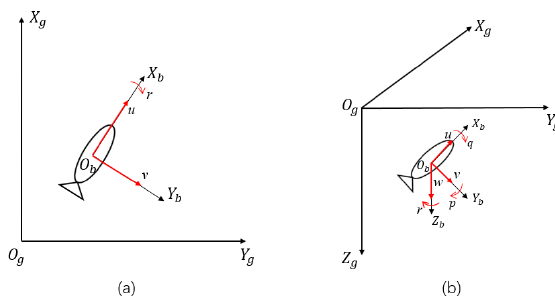
Fig. 3 Motion of an AUV in (a) 2D and (b) 3D space.